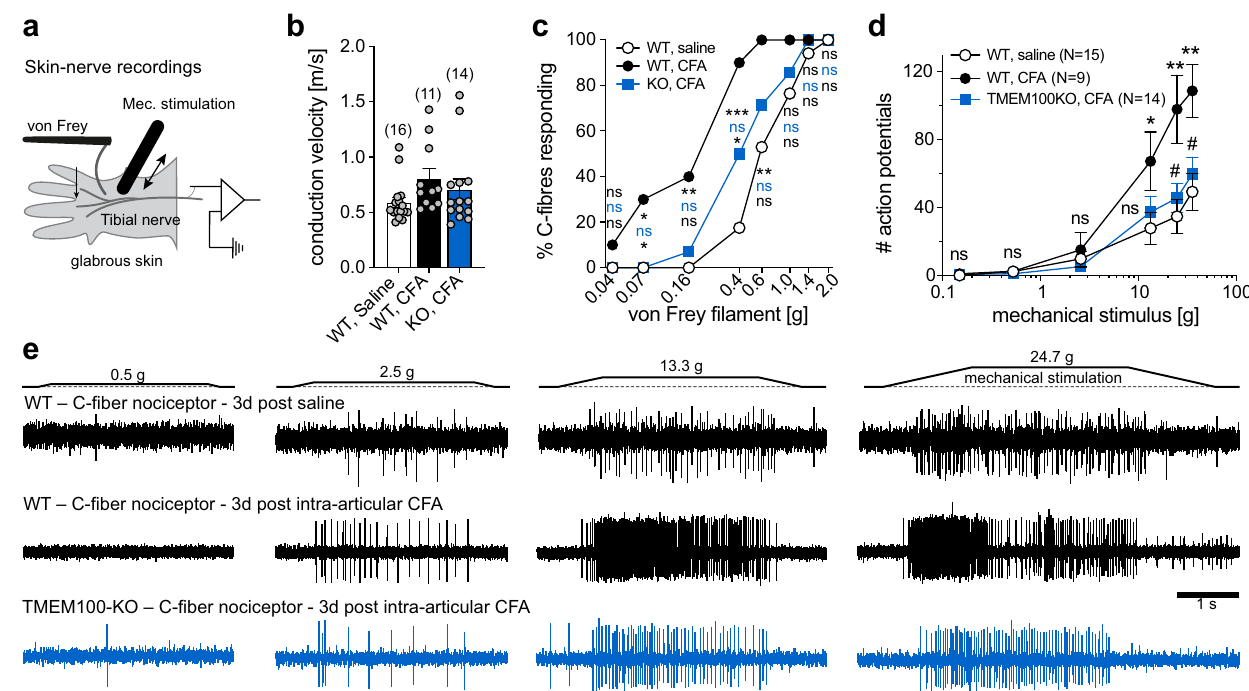
Fig.6|SensitizationofcutaneousC- fi bernociceptorscontributestosecondary mechanical hypersensitivity. a Cartoon depicting the experimental approach. b Scatter dot plots of the conduction velocities [m/s] of the examined afferent fi bers from the indicated mice. Bars represent means±SEM. c Comparison of the proportionsofC- fi bernociceptorsthatrespondtomechanicalstimulationwiththe indicated von Frey fi laments. The proportions were calculated from all C- fi bers (same N-numbers as in b) recorded from 3 different mice per group and were compared pairwise using the two-sided Chi-square test. P -values (ns, P >0.05; * P <0.05;** P <0.01,*** P <0.001)areprovidednexttothesymbolsinthegraphand refertoWT-salinevs.WT-CFA(top,black),WT-salinevs.TMEM100KO-CFA(middle, blue) and WT-CFA vs. TMEM100KO (bottom, black). Exact P -values are provided